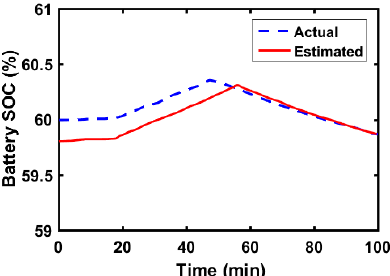
Figure 20. Comparison between actual and estimated SOC using the proposed technique.